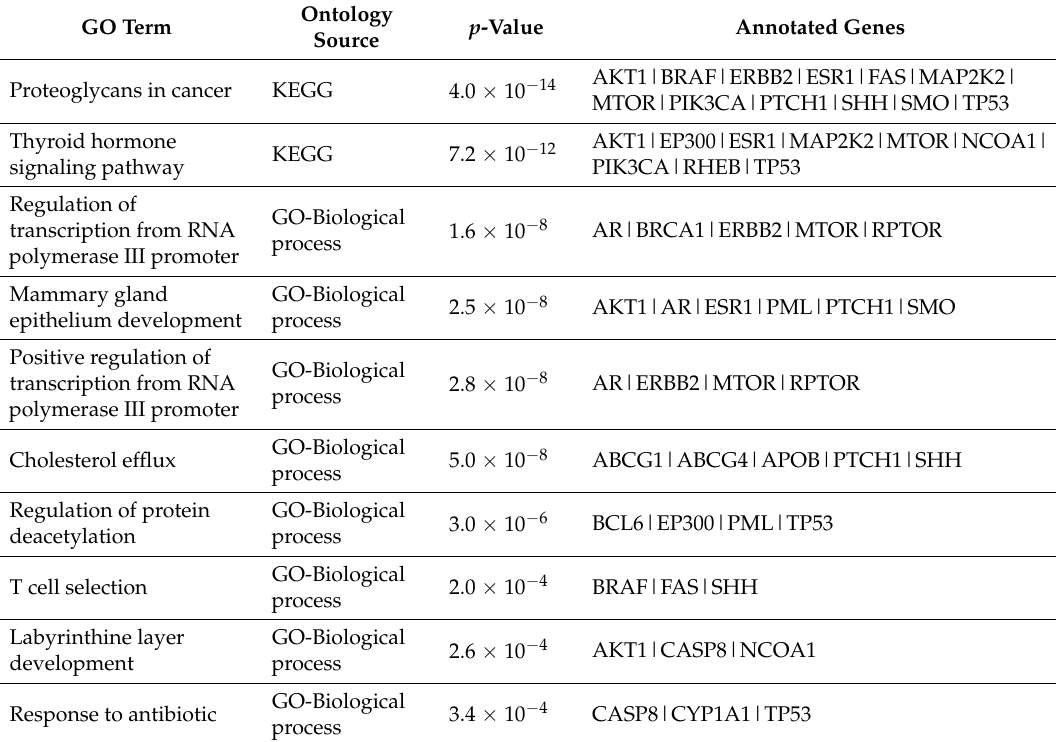
AKT1, CASP8, TP53, FAS Note: Score = ∑ Degree centrality of interacting genes. Table 4. Significantly enriched KEGG pathways and biological process GO terms associated with the 27 genes common between EDCs and breast cancer and the 20 predicted genes produced by